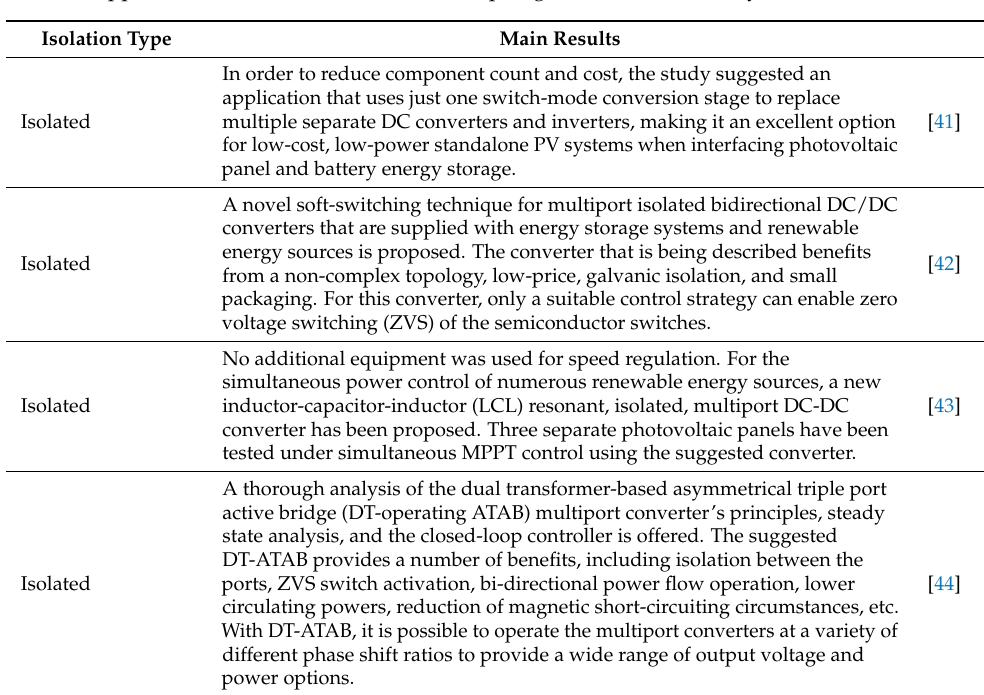
Table 3. Application of different isolated MPC topologies for RES and EV